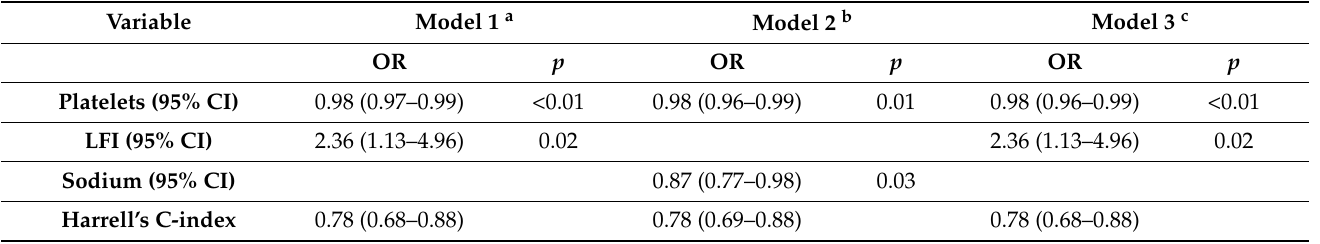
Table 2. Multivariable analyses of risk factors for 30-day rehospitalization in patients with